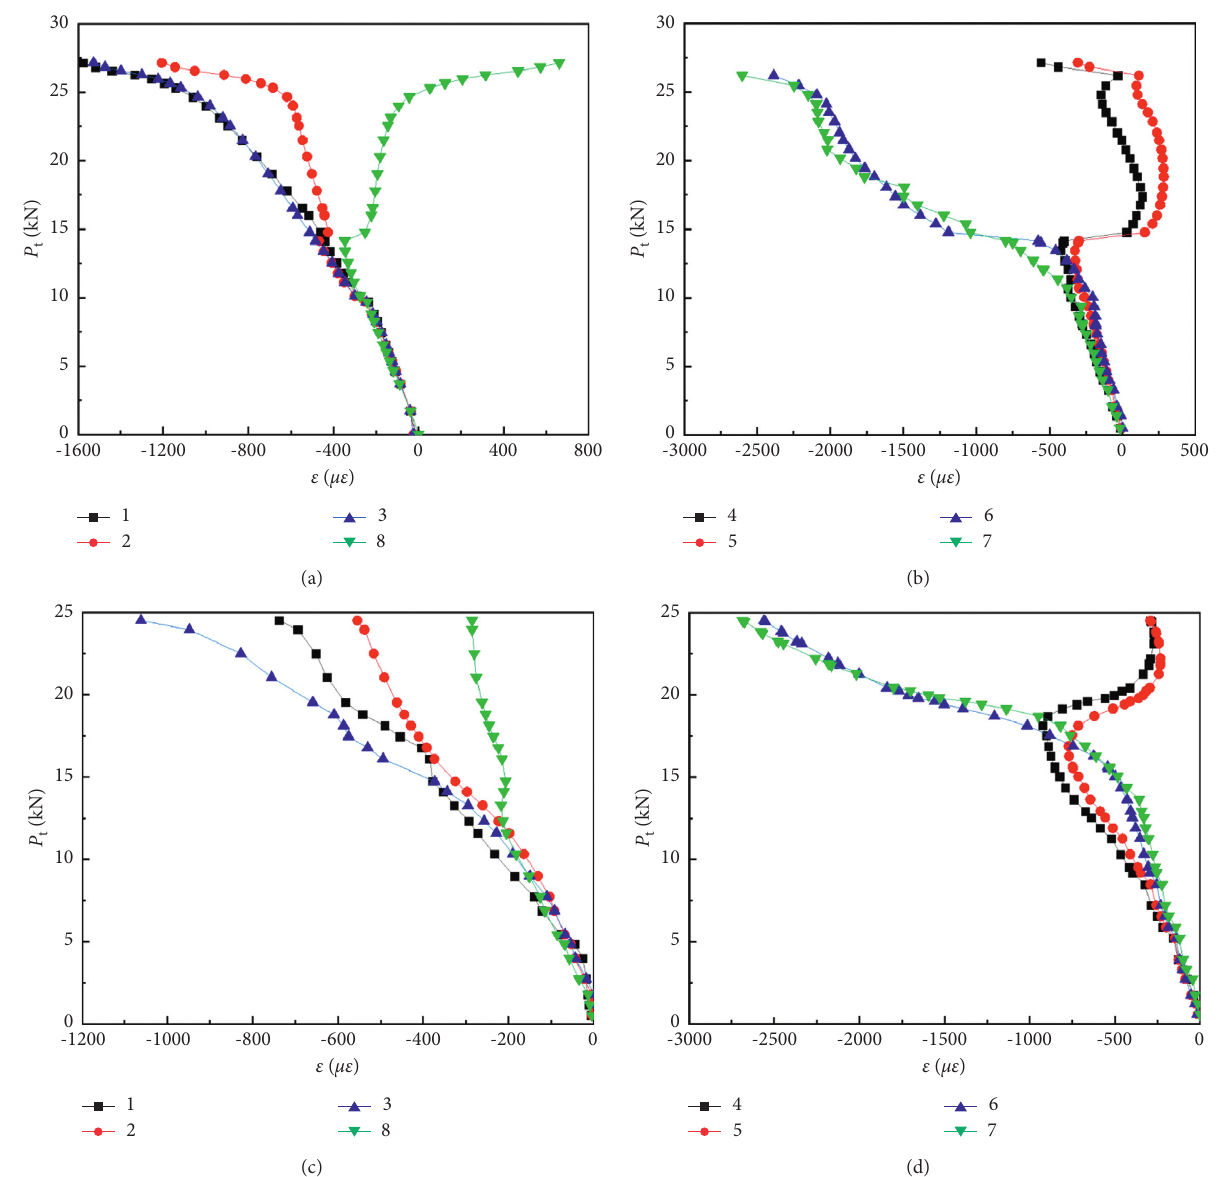
Figure 14: Load versus strain curve of section C80-10. (a) Specimen C80-10-1H3-1. (b) Specimen C80-10-1H3-1. (c) Specimen C80-10- 1H7-1. (d) Specimen